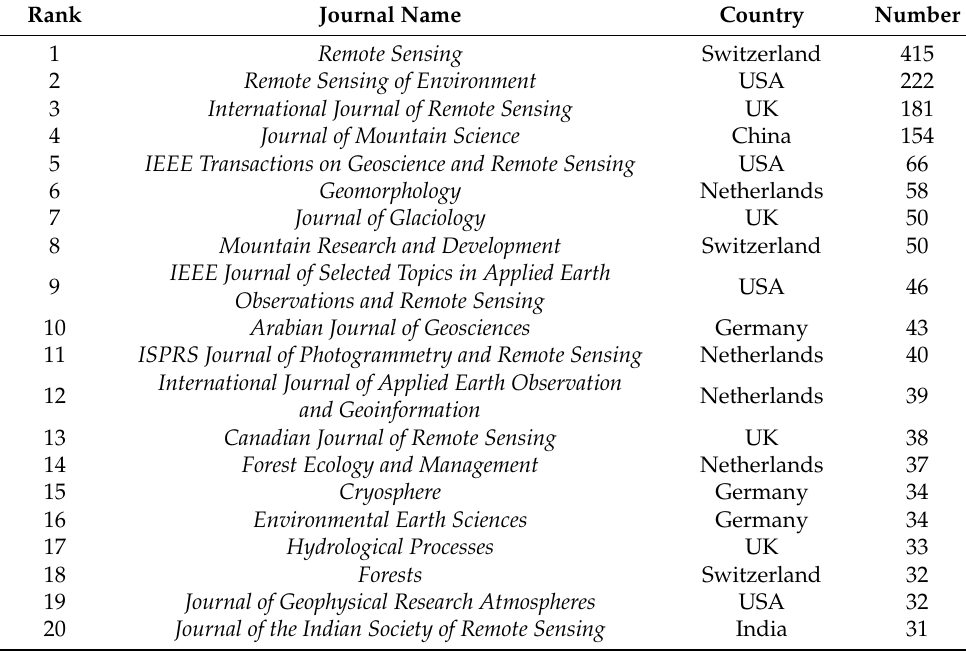
Table 1. Top 20 main source journals, country, and the total number of